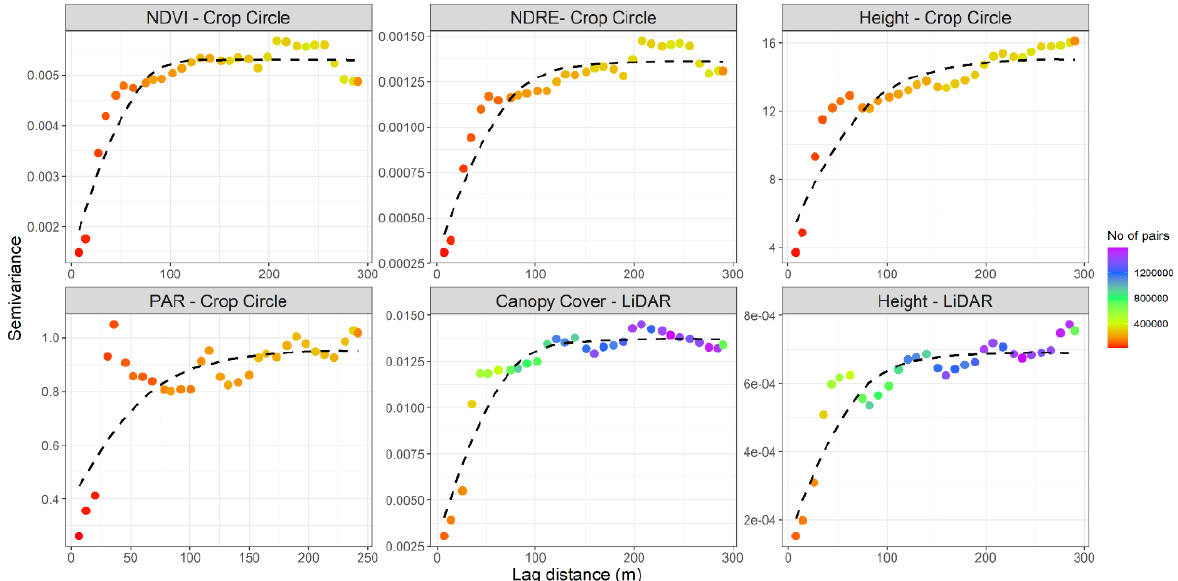
Figure 8. Variograms of each parameter derived from the Crop Circle and LiDAR scanning. NDVI, normalized difference vegetation index; NDRE, normalized difference red-edge index; PAR, photosynthetic active radiation (ratio between reflected and incident radiation).